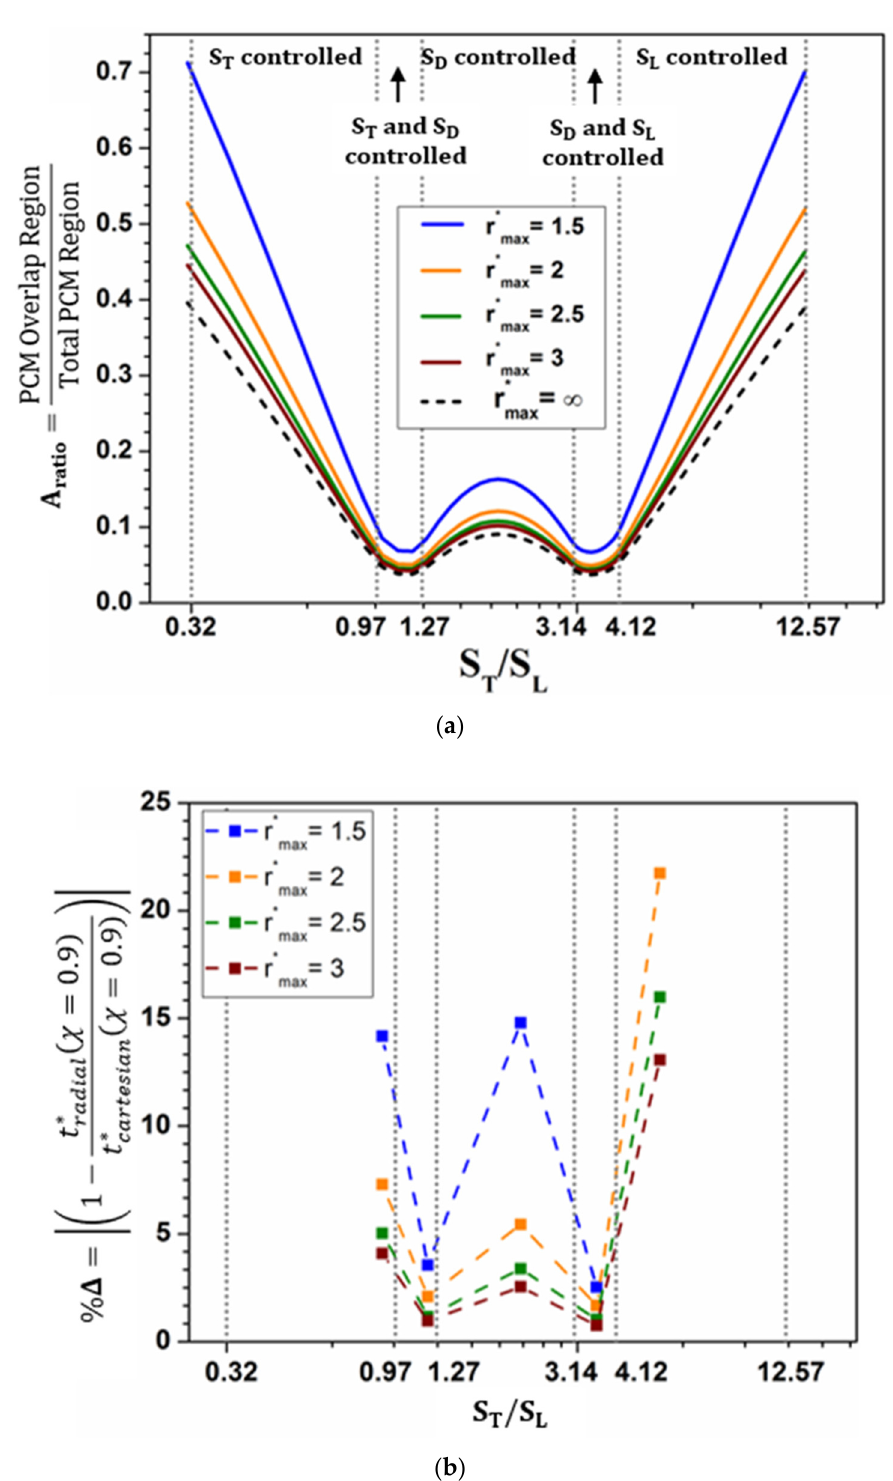
Figure 12. The effect of the ( a ) normalized overlap area ( A ratio , see Equation (2)) and ( b ) the percentage deviation, % ∆ , between the performance parameters of 1D ROM and 2D CFD Cartesian model, on S T / S L for discrete values of r ∗ max From the above discussion, a test ‐ case scenario was set up with 𝑆 (cid:3021) /𝑆 (cid:3013) (cid:3404) 1.2 and 𝑟 (cid:3040)(cid:3028)(cid:3051)∗ (cid:3404) 3 , such that the overlap effect ( 𝐴 (cid:4667) and percentage error ( %Δ ) are the minimum. (cid:3045)(cid:3028)(cid:3047)(cid:3036)(cid:3042)